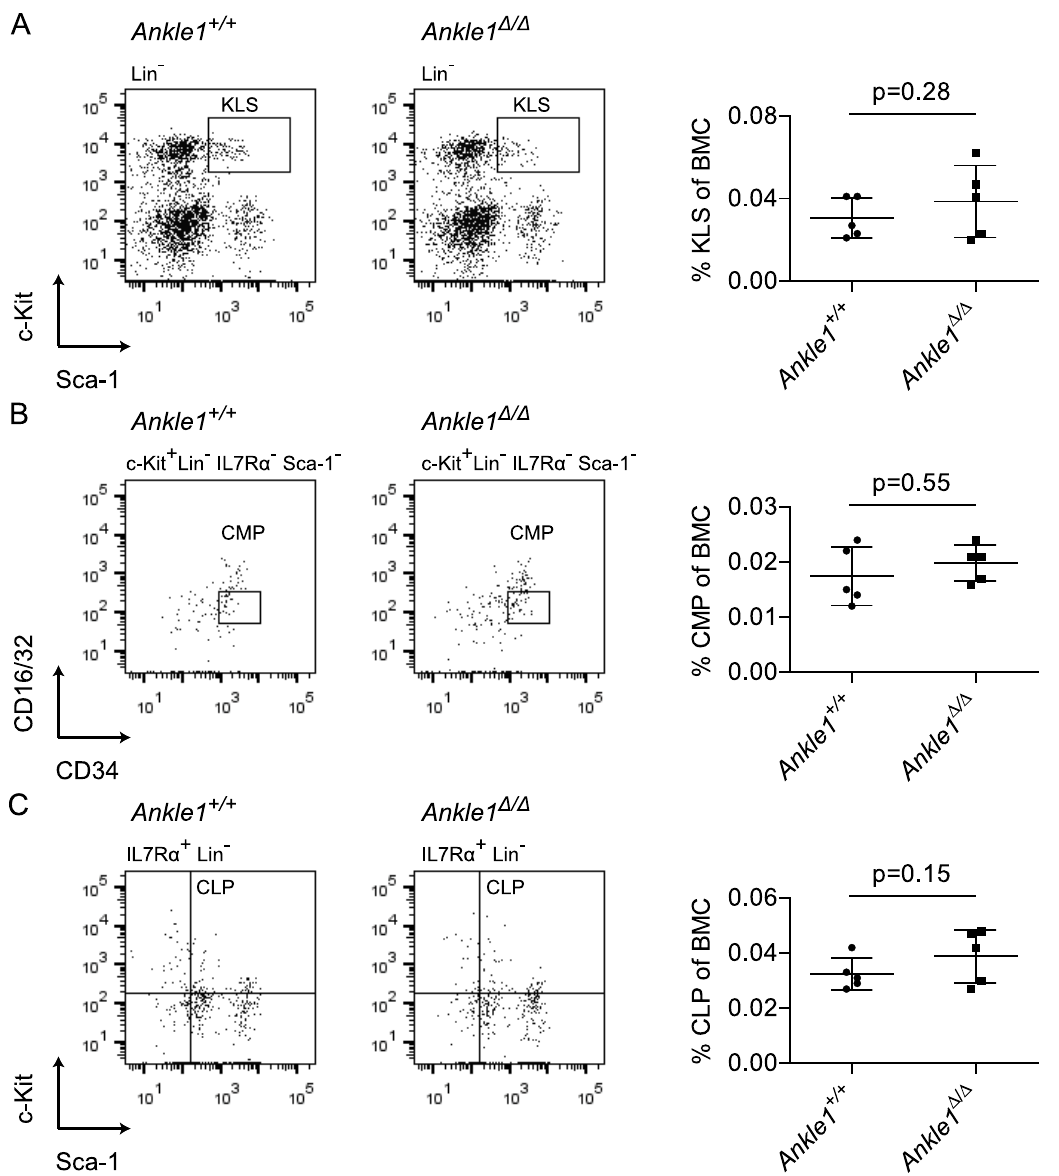
Fig 3. Flow cytometric analysis of early hematopoietic development in 9 – 10 months old Ankle1 Δ / Δ mice. (A) Representative dot plot of lineage negative bone marrow cells (BMCs) of an Ankle1 +/+ and an Ankle1 Δ / Δ mouse and relative quantification of the KLS cells (c-Kit+ and Sca-1+, boxed) depicted in a scatter plot; (B) Representative dot plot of c-Kit+ Lin- IL7R α - Sca-1- BMCs of an Ankle1 +/+ and an Ankle1 Δ / Δ mouse and relative quantification of the boxed, CD16/32 low CD34 + common myeloid progenitors (CMPs) in a scatter plot; (C) Representative dot plot of IL7R α + Lin - BMC of an Ankle1 +/+ and an Ankle1 Δ / Δ mouse and relative quantification of the c-Kit + Sca-1 + , common lymphoid progenitors (CLPs) depicted in a scatter plot; scatter plots indicate the mean (n = 5), error bars: standard deviation, paired students t test was used for determination of statistical significant differences (p (cid:1) 0.05).